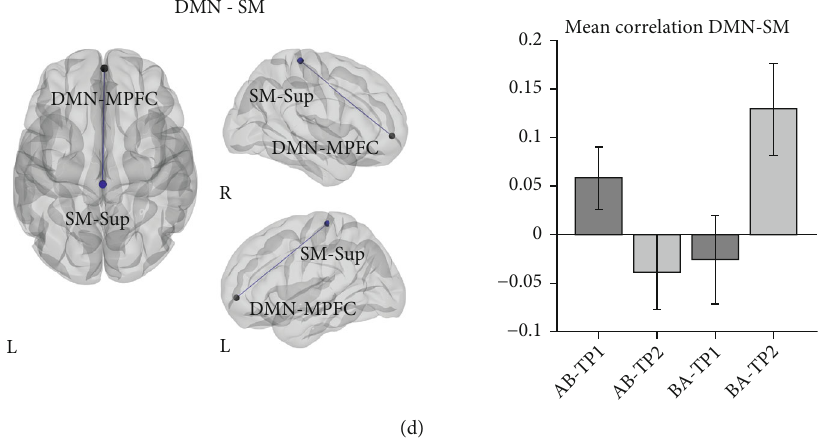
Figure 1: Changes in between-network connectivity induced by the neurological music therapy intervention. Nodes are overlaid on a rendered semitransparent brain generated using CONN. Connectivity matrices display the mean post- minus pre-intervention (a – c) Fisher-transformed Z -score correlation values for each node. The bar plots (d) show the e ff ect size of the AB > BA and TP2 > TP1 interaction represented by the Fisher-transformed Z-score correlation values for each node. FPN: frontoparietal; SM: sensorimotor; DAN: dorsal attention; VIS: visual; DMN: default mode network; FEF: frontal eye fi eld; IPS: intraparietal sulcus; LPFC: lateral prefrontal cortex; LAT: lateral; MED: medial; MPFC: medial prefrontal cortex; OCC: occipital; PCC: posterior cingulate cortex; PPC: posterior parietal cortex; Sup: superior; R: right; L: